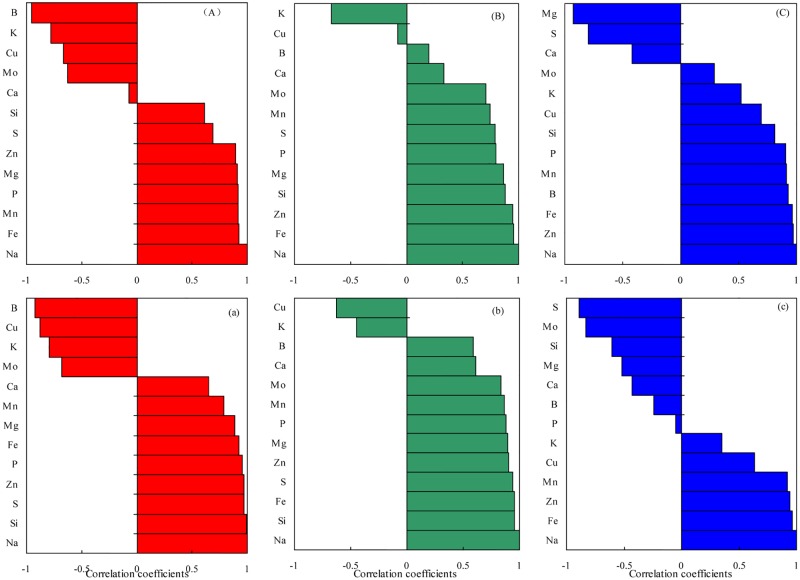
Correlation coefficients between Na and other elements under NaCl treatment.(A), (B), and (C) stand for the root, stem, and leaf of L24, respectively; (a), (b), and (c) stand for the root, stem, and leaf of X45, respectively.